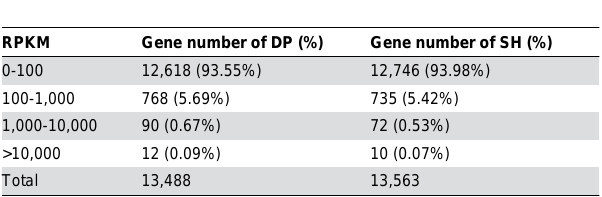
Table 4. A summary of the cSNPs by nucleotide change.